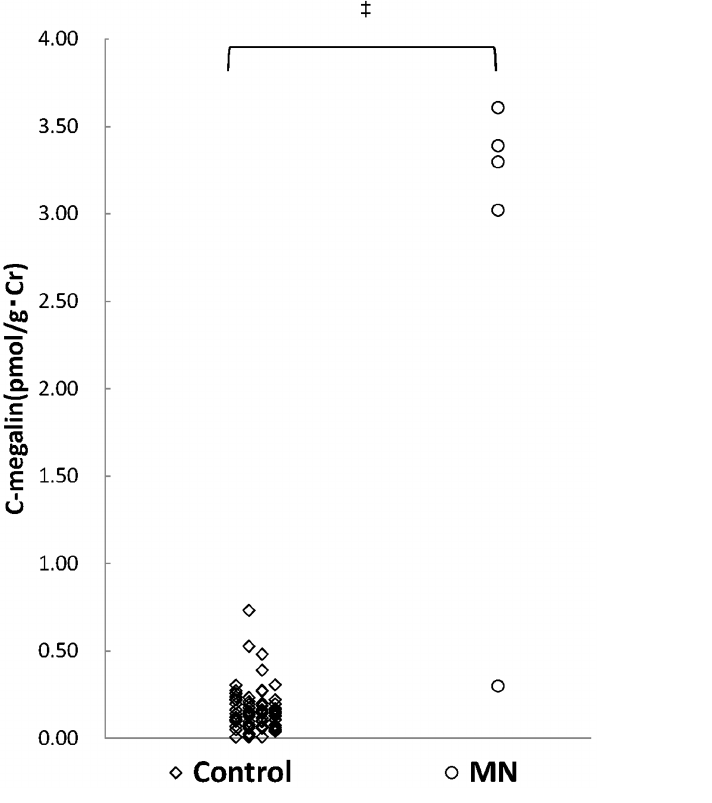
Fig. 3. The levels of urinary C-megalin in patients with membranous nephropathy. MN: membranous nephropathy. { , p , 0.001